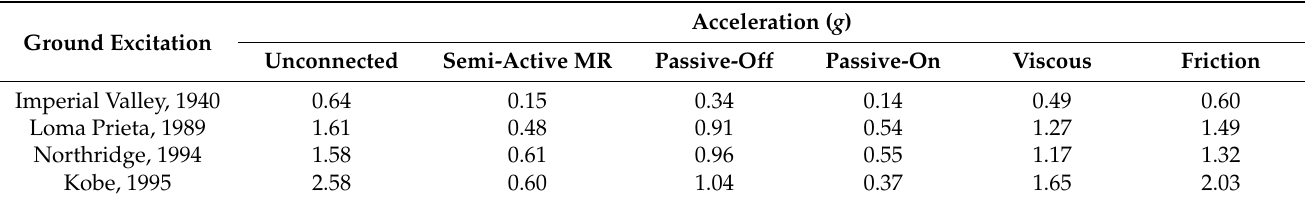
Table 8. Comparison of top storey peak acceleration of the coupled flexible building under different control strategies when dampers are arranged in Configuration 1.